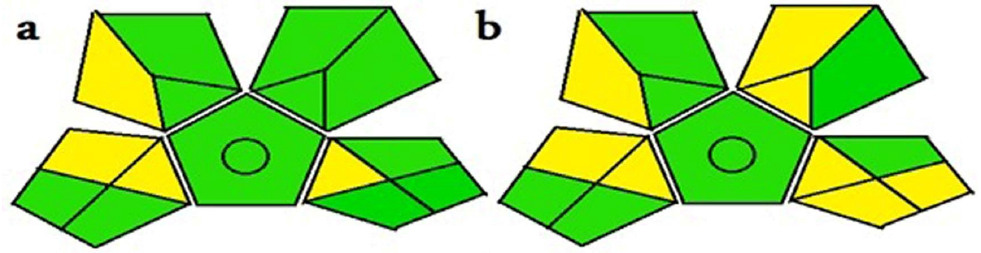
Figure 2. GAPI pictograms for ( a ) the proposed green HPTLC method and ( b ) the proposed green HPLC method.